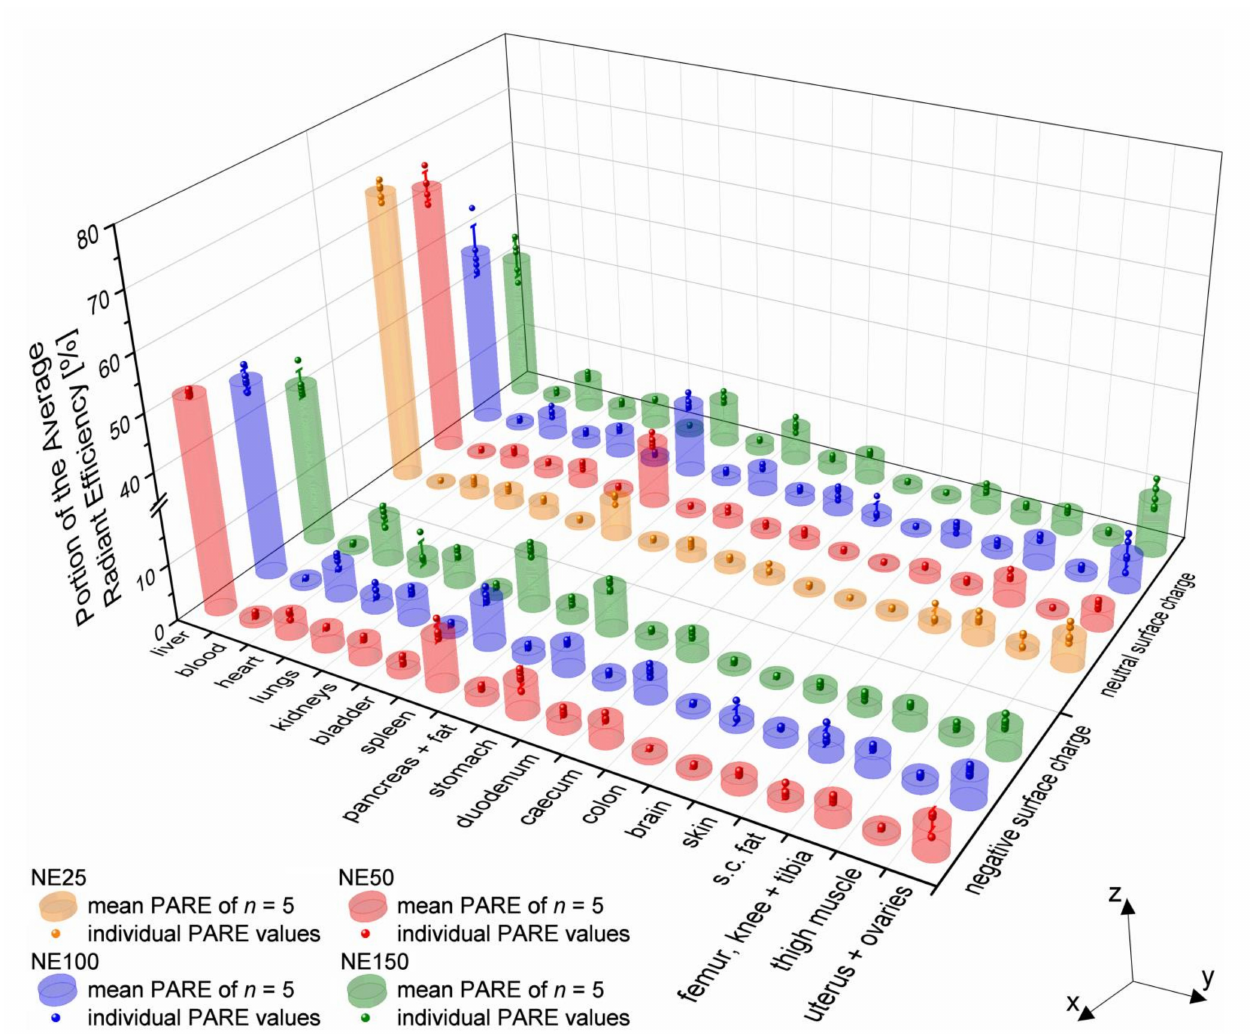
Figure 10. 3D bar and scatter chart of the PARE of the ex vivo excised organs and blood, 24 h after i.v. injection of the three negatively surface-charged nanoemulsions and additionally four previously investigated neutral surface-charged nanoemulsions